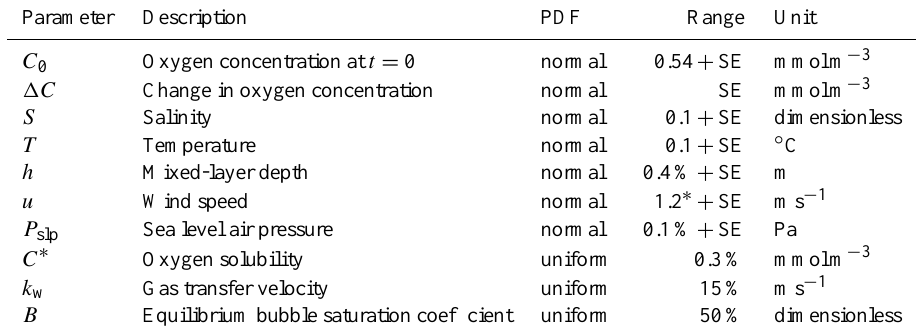
Table 2. Parameters and their uncertainty distributions used for LHS/PRCC and eFAST at the Warp site. Parameter Description PDF Range Unit C 0 Oxygen concentration at t = 0 normal 0.54 + SE mmolm − 3 (cid:49)C Change in oxygen concentration normal SE mmolm − 3 S Salinity normal 0.1 + SE dimensionless T Temperature normal 0.1 + SE ◦ C h Mixed-layer depth normal 0.4% + SE m u Wind speed normal 1.2 ∗ + SE ms − 1 P slp Sea level air pressure normal 0.1% + SE Pa C ∗ Oxygen solubility uniform 0.3% mmolm − 3 k w Gas transfer velocity uniform 15% ms − 1 B Equilibrium bubble saturation coefficient uniform 50% dimensionless SE: the standard error of the